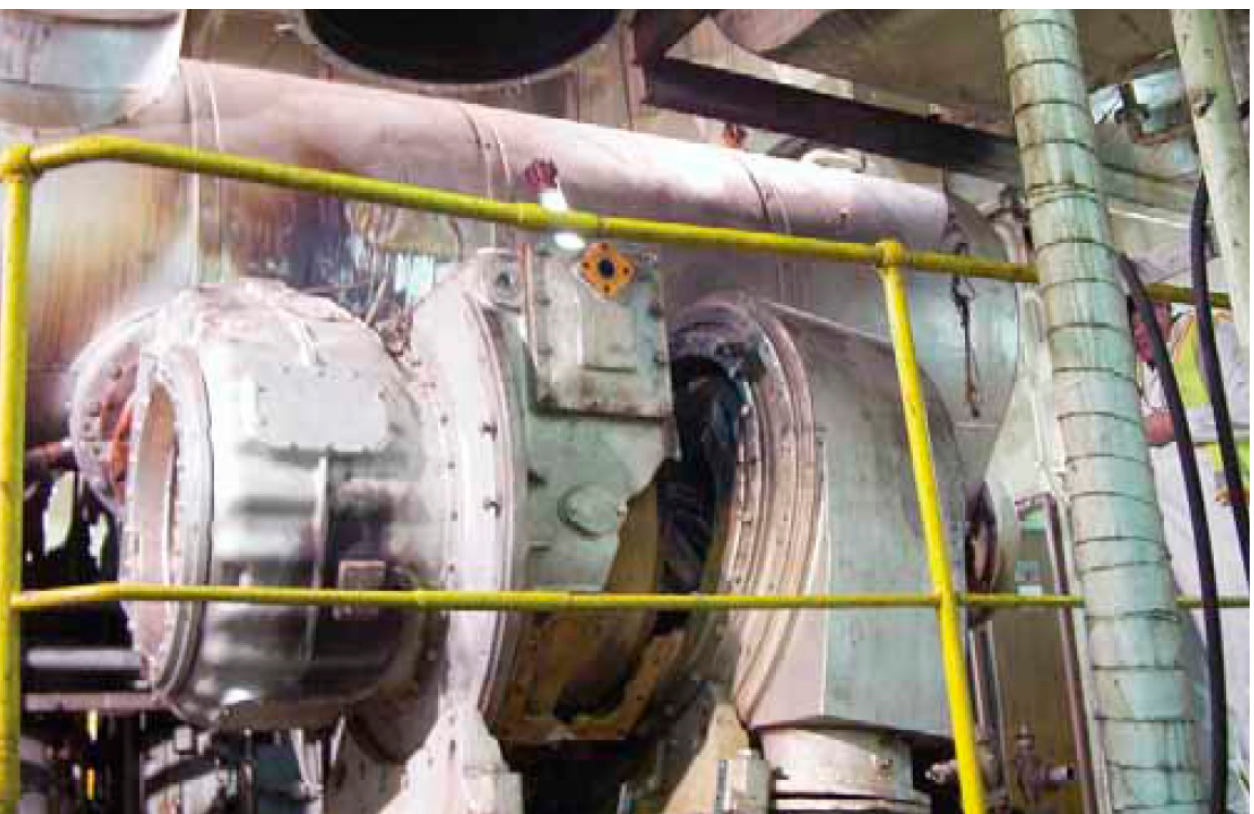
Figure 1. View of contaminated scavenging ports in the sleeve of cylinder No. 2 of the main engine of the m/v Goliath (Australian Transport Safety Bureau, 2006).